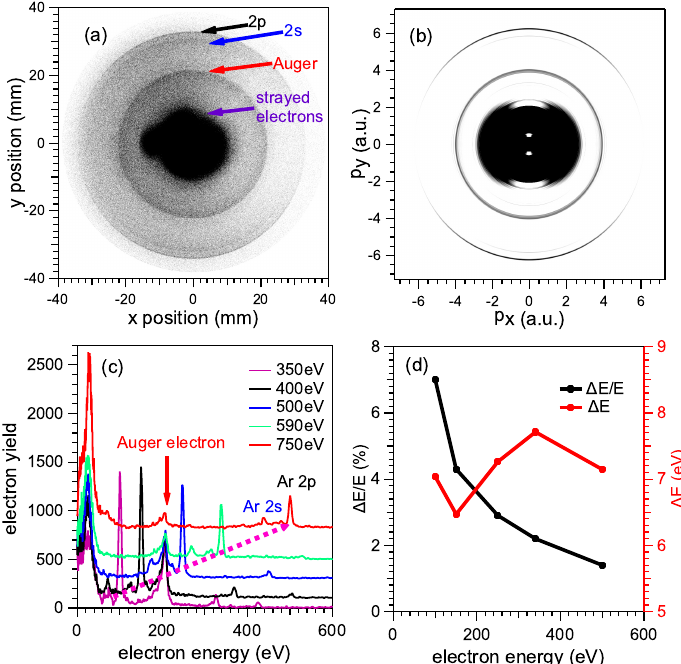
Figure 4. ( a ) The raw electron image of Ar ionized at the photon energy of 750 eV. ( b ) The slice at p z = 0 of the 3D-momentum distribution after inverse Abel transformation. ( c ) The photoelectron spectra were obtained by angular integration of the complete 3D momentum distribution at different photon energies from 350 to 750 eV. ( d ) Electron kinetic energy resolution ∆ E / E and ∆ E as a function of electron kinetic energy. Table 1. List of the performance of VMI spectrometers tested by measurements.